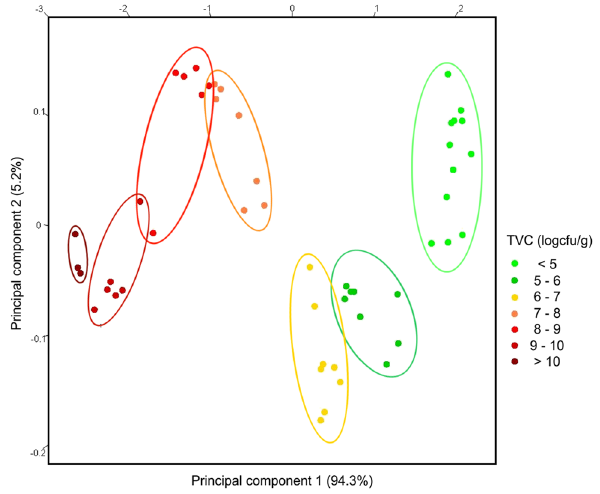
Figure 13: PCA plot of random samples of rainbow trout. The color of the points indicates the log ( TVC ) according to the scale on the right. Reprinted with permission from ref. [ 75 ] .